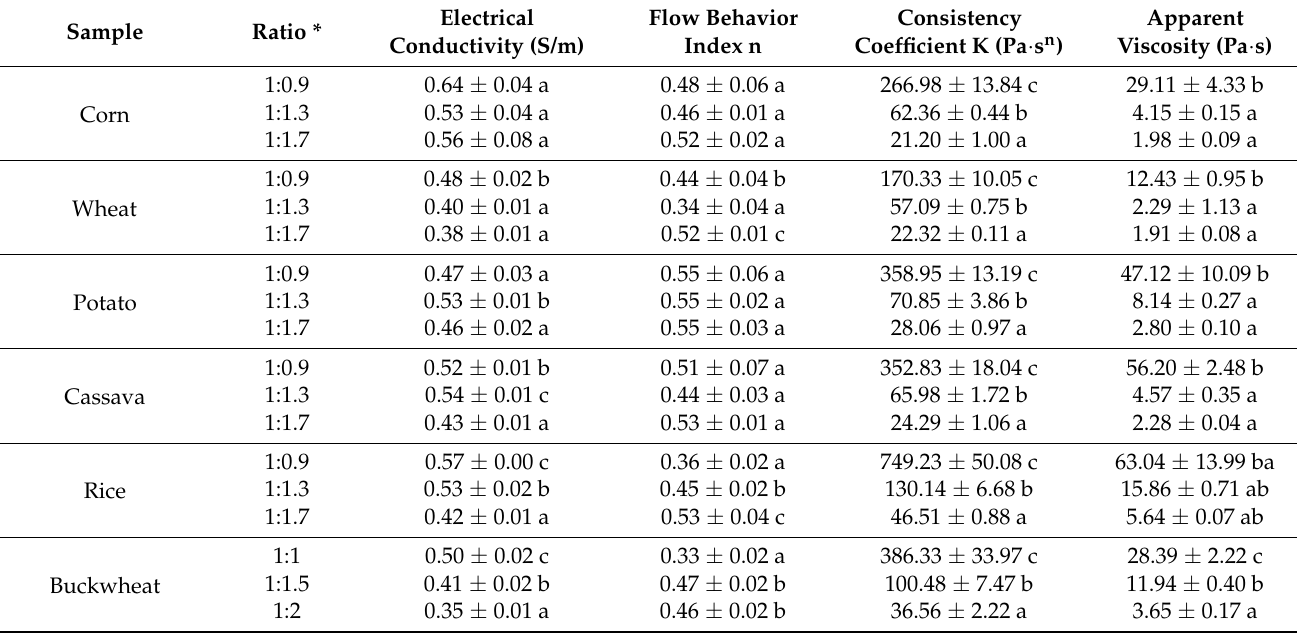
Table 3. Effect of water content on the rheological and electrical properties of gluten-free batter made from various flours/starch.